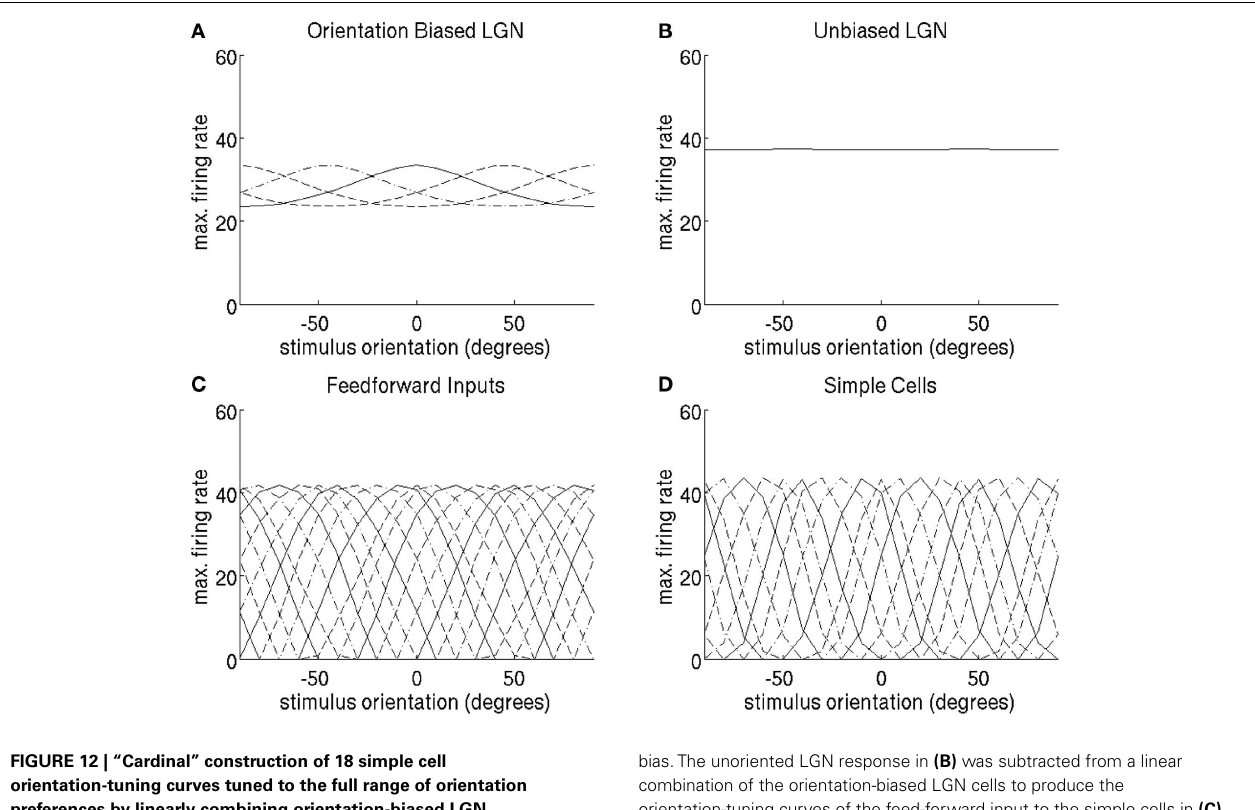
FIGURE 12 | “Cardinal” construction of 18 simple cell orientation-tuning curves tuned to the full range of orientation preferences by linearly combining orientation-biased LGN cells with only four orientation biases. Orientation-tuning curves were obtained by stimulating with a bar of length 4.16˚. (A) The orientation-tuning curves of the four LGN cells with orientation